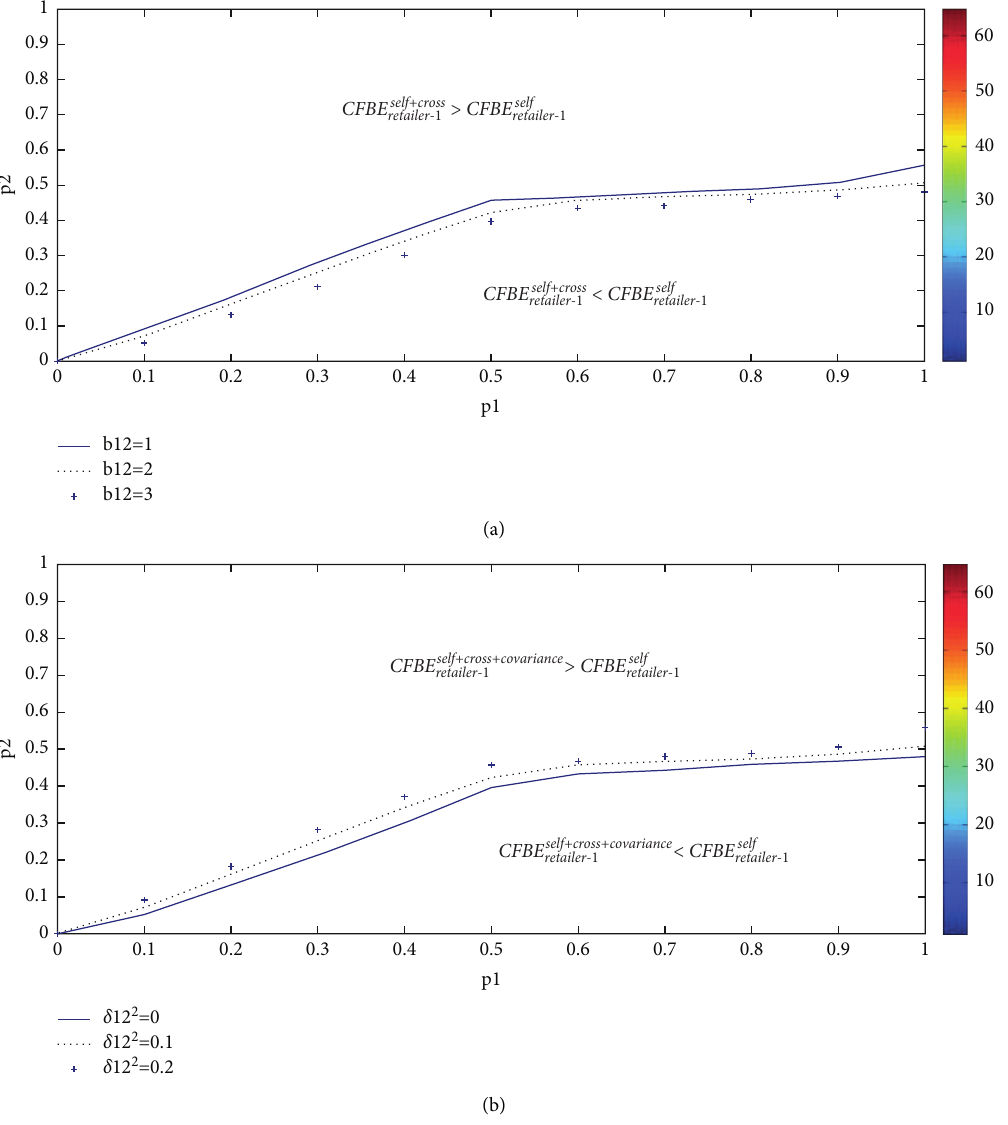
Figure 2: (a) The impact of b CFBE self + cross + covariance retailer − 1